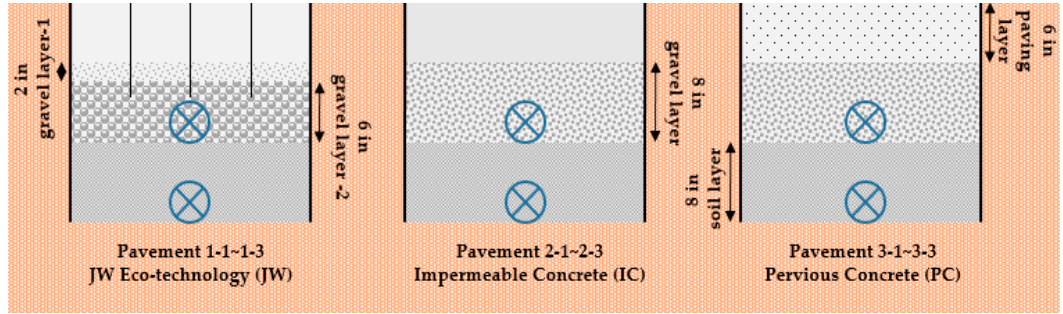
Figure 5. Cross-sections of the three pavement systems.